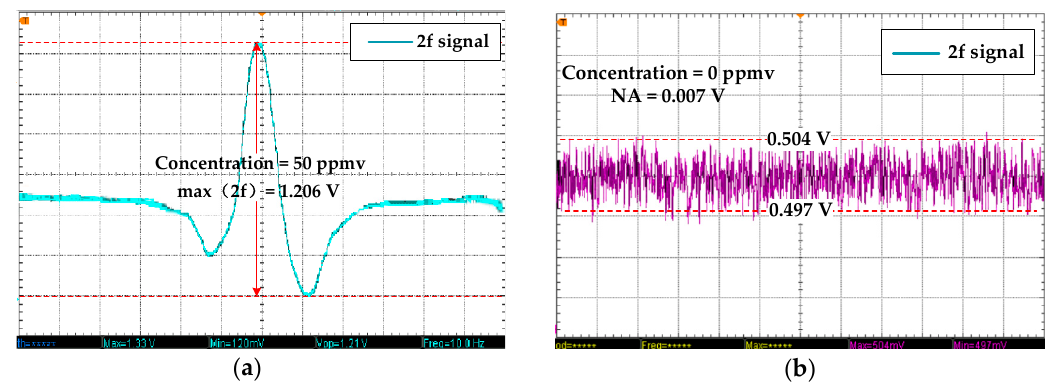
Figure 7. ( a ) 2f SA of 50 ppmv C 2 H 2 . ( b ) 2f SA of 0 ppmv C 2 H 2 .